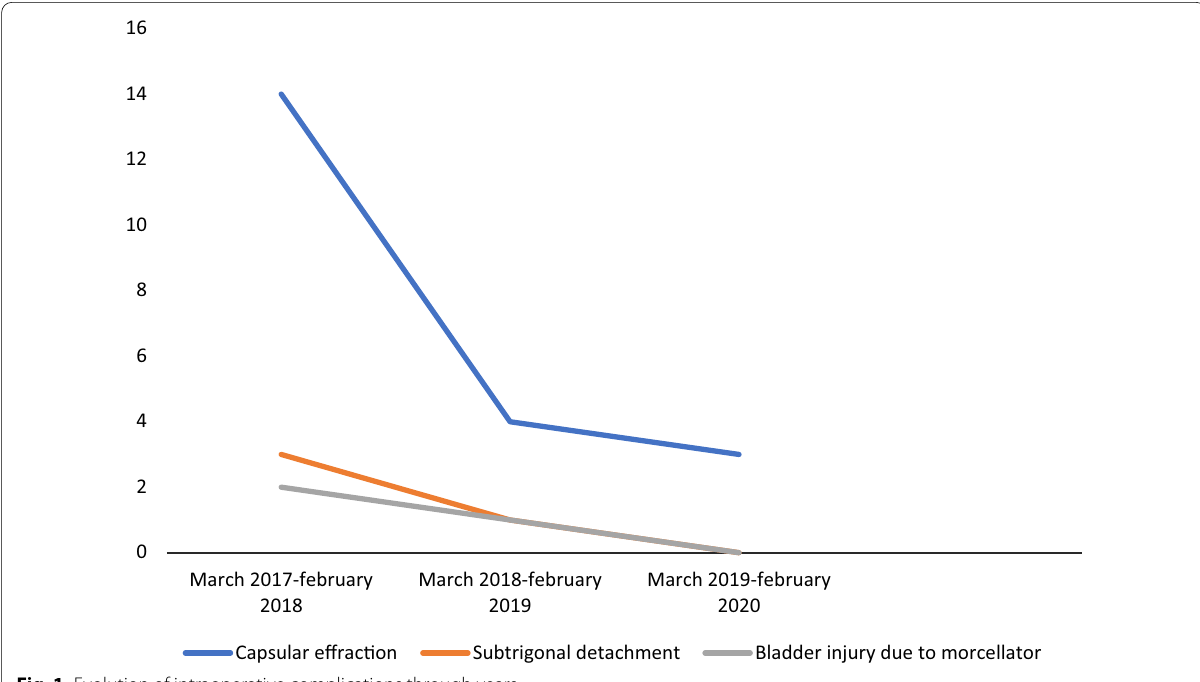
Fig. 1 Evolution of intraoperative complications through